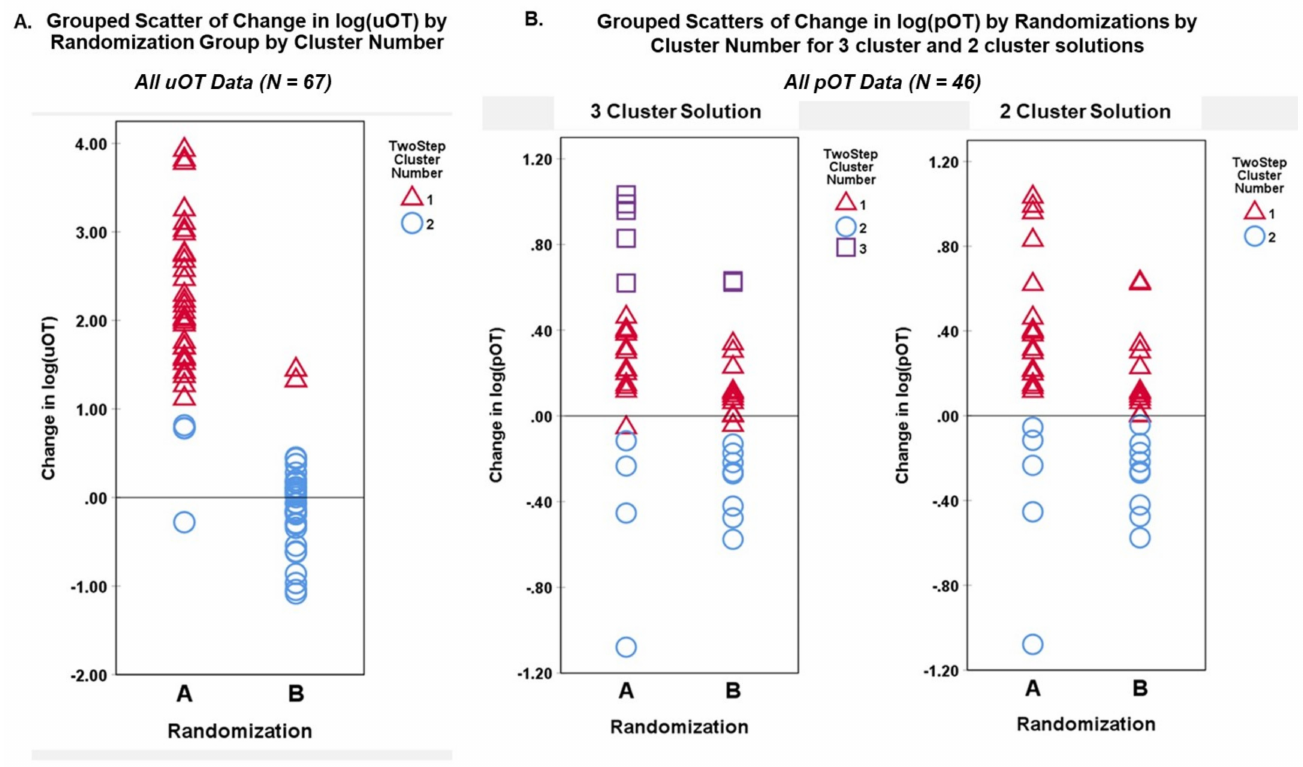
Figure 5. Grouped scatterplots of cluster membership variables for each TSC solution were plotted against the actual Randomization Group and log(OT) change for ( A ) urine and ( B ) plasma